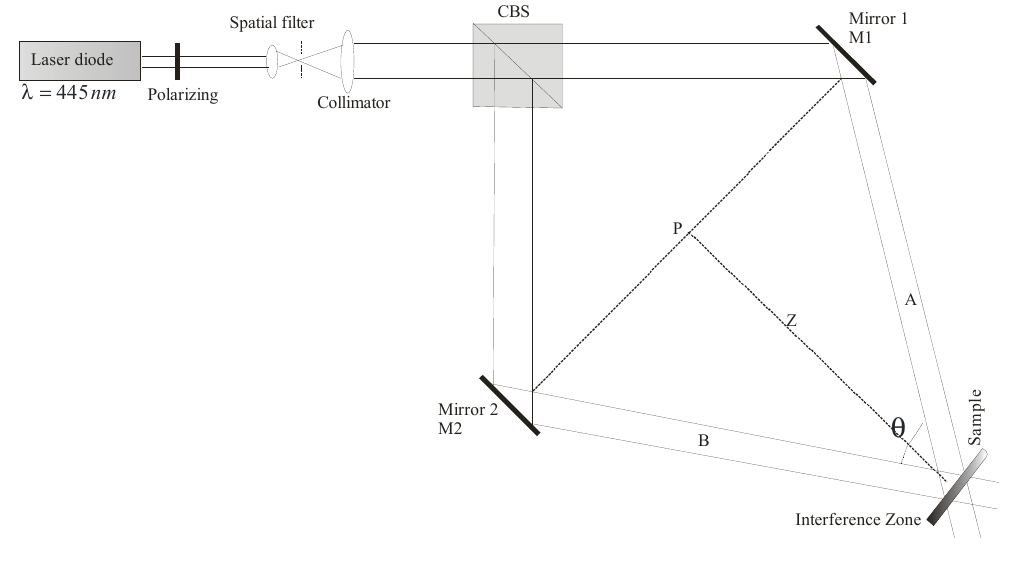
Figure 2. Experimental setup for recording holographic gratings. CBS: cube beam